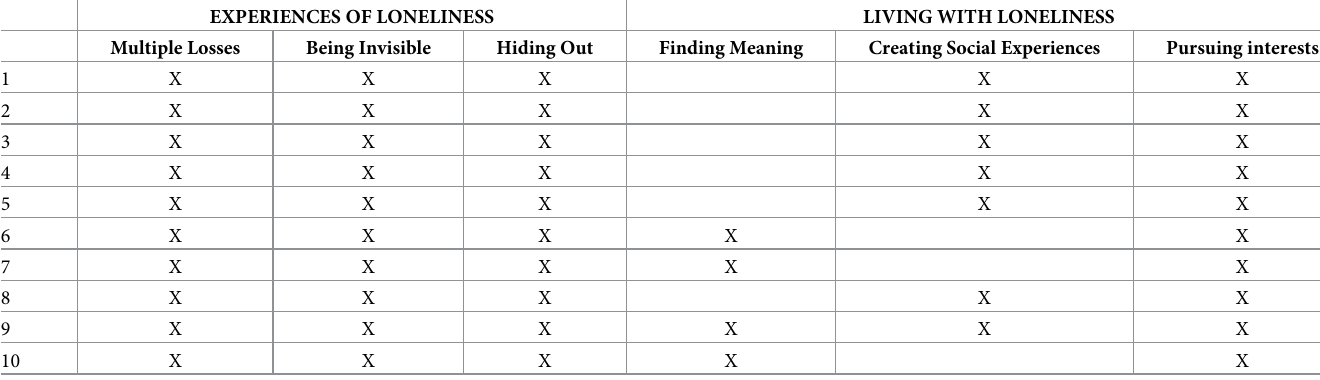
Table 2. Emergent themes.